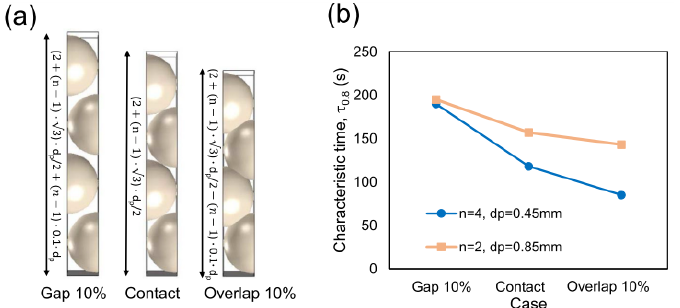
Figure 8. ( a ) Illustration of granulated beds with different contact geometry; ( b ) Characteristic time τ 0.8 for different contact geometry. Reprinted/adapted with permission from Ref. [109]. (Copyright 2016), Elsevier.